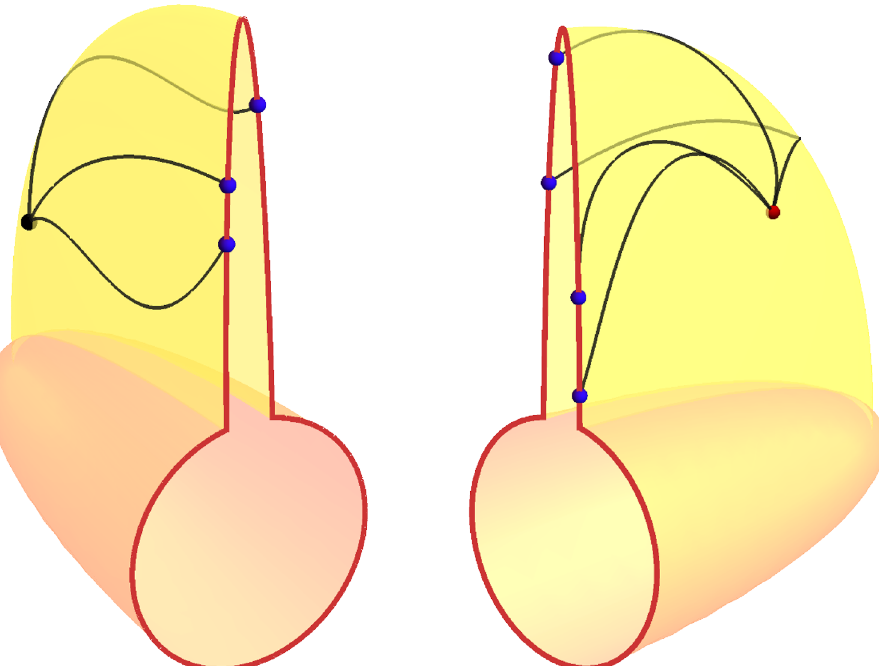
Figure 5 . Illustration of Witten diagrams on the grSK geometry computing 3 and 4-point in(cid:13)uence functions of the boundary (cid:12)eld theory. The boundary operator insertions (blue) lie on the thermal SK contour. The bulk (cid:12)eld is constructed using the boundary-bulk propagators, and the bulk vertex is integrated over the Lorentzian section of the grSK